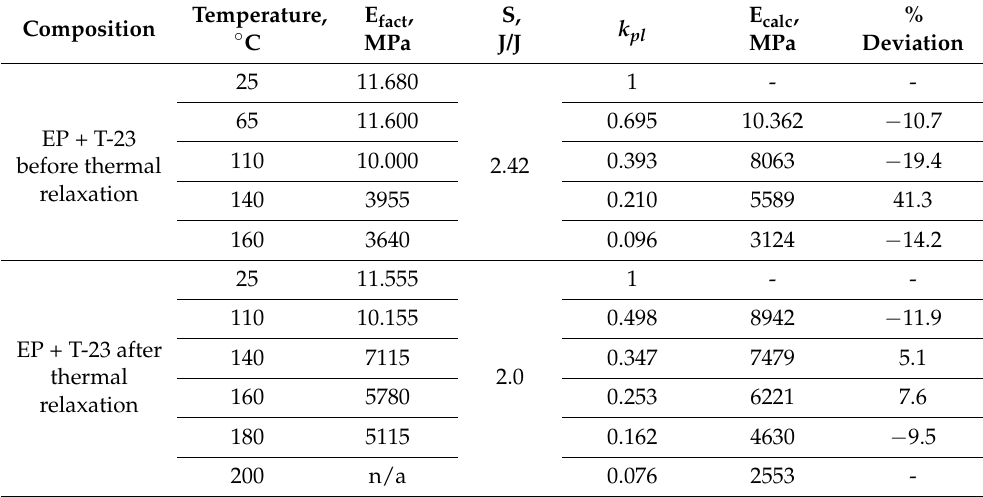
Table 4. Comparative actual and calculated data of the modulus of elasticity of fiberglass plastics on epoxy resin and glass fabric T-23 when heated before and after thermal relaxation.